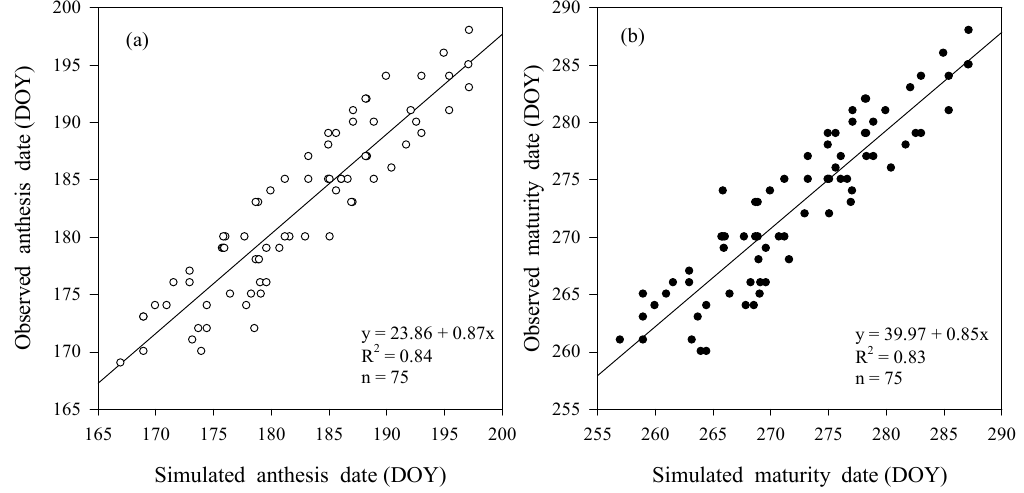
Figure 9. Observed and simulated dates of onset of phenological stages anthesis ( a ; unfilled symbol; left) and maturity ( b ; filled symbols; right) for cotton in Punjab, Pakistan, during 1983 − 1985; DOY; day of year.